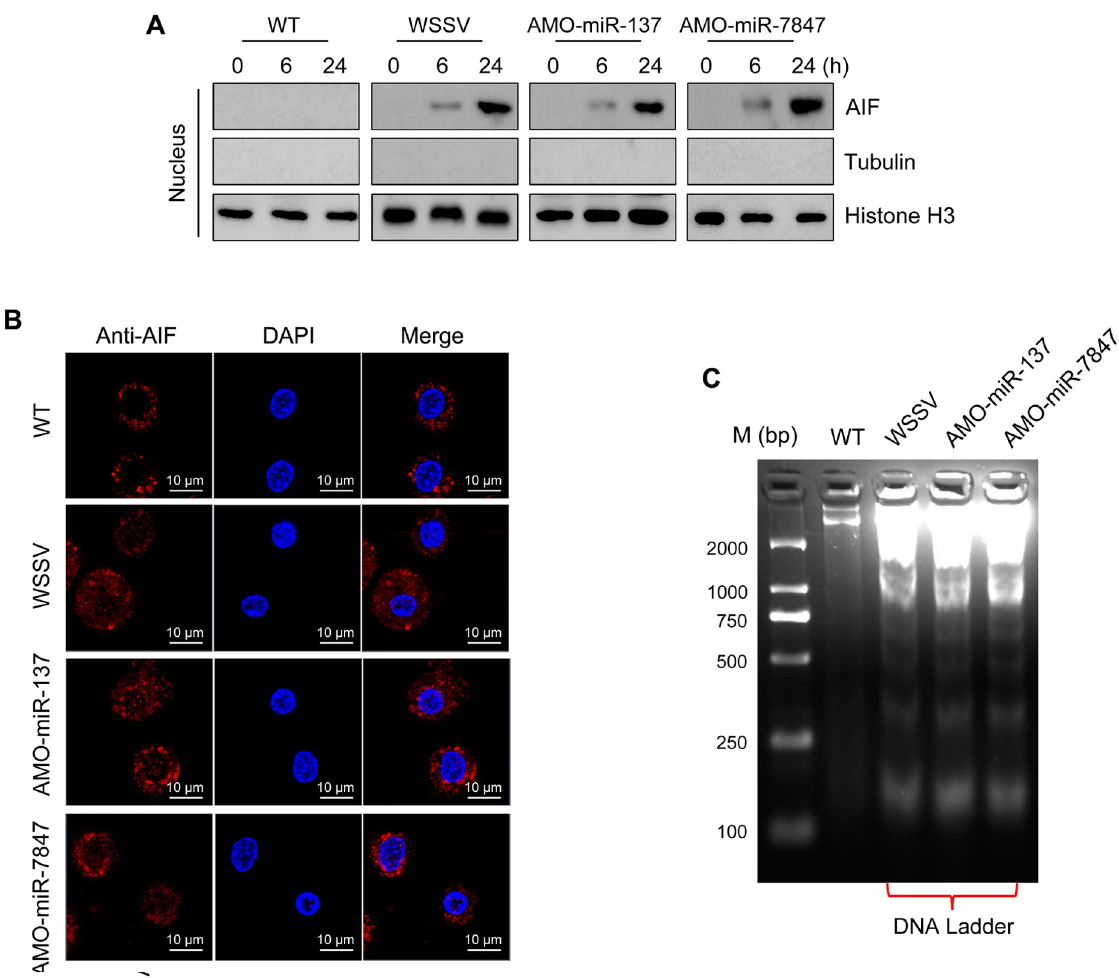
Fig 6. AIF translocated into nucleus to mediate DNA fragmentation. (A) The protein level of AIF in the nucleus, mud crabs were treated with WSSV, AMO-miR-137 and AMO-miR-7847 separately, at 0, 6 and 24 h after the treatments, the nucleus of hemocytes were isolated and subjected to western blot analysis. Tubulin and Histone H3 were used to evaluate the purity of the isolated nucleus. (B) Immunofluorescent assay was performed to detect the localization of AIF in mud crab hemocytes after specific treatment, including AMO- miR-137, AMO-miR-7847 and WSSV. Scale bar, 10 μ m. (C) DNA Ladder detection of mud crab treated with AMO-miR-137, AMO-miR- 7847 and WSSV separately, then the genomic DNA was isolated and subjected to agarose gel